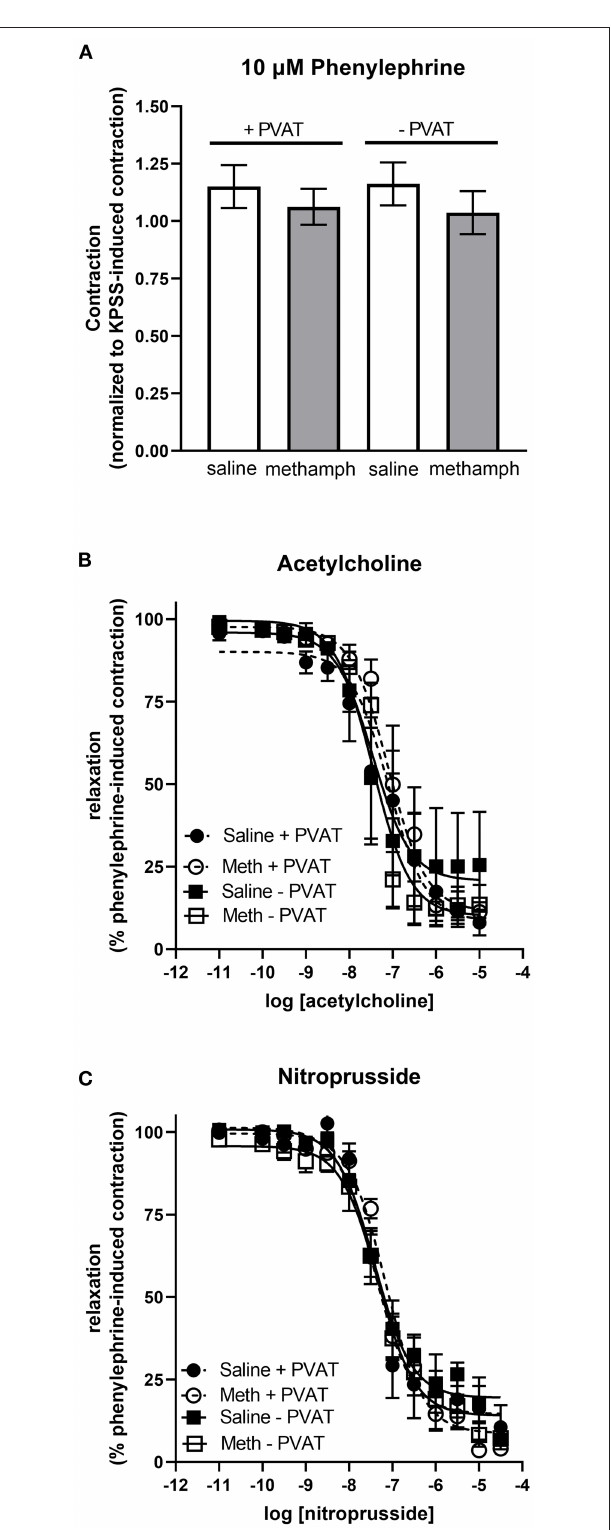
FIGURE 6 | Impact of prenatal methamphetamine on acetylcholine and nitroprusside induced relaxation in third order mesenteric arteries from